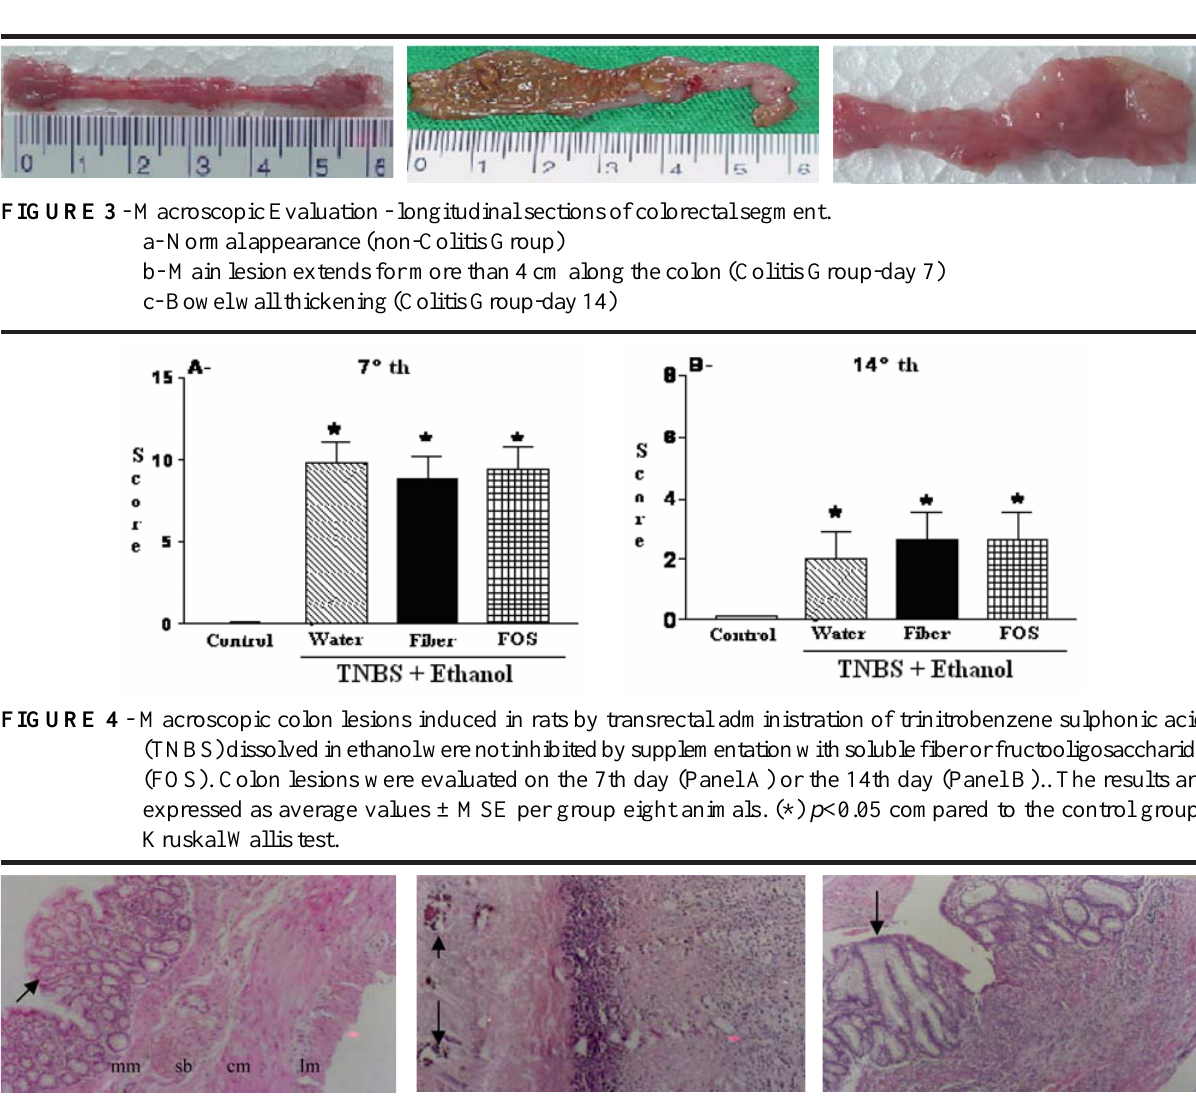
FIGURE 5 - Microscopic Evaluation - Photomicrograph showing longitudinal sections of colorectal segment. a - Mucosal membrane with intact Lieberkühn crypts (arrow) and abundant globet cells. mucosal muscle (mm); submucosal (sb), circular muscle (cm), longitudinal muscle (lm). HE 40X. (non-Colitis Group) b - The inflammatory process progressed with loss of the mucosal architecture, decrease of globet cells, necrose (arrow) and increase of inflammatory cell infiltration along the entire colon wall by the 7th day following induction with TNBS. HE 100X.